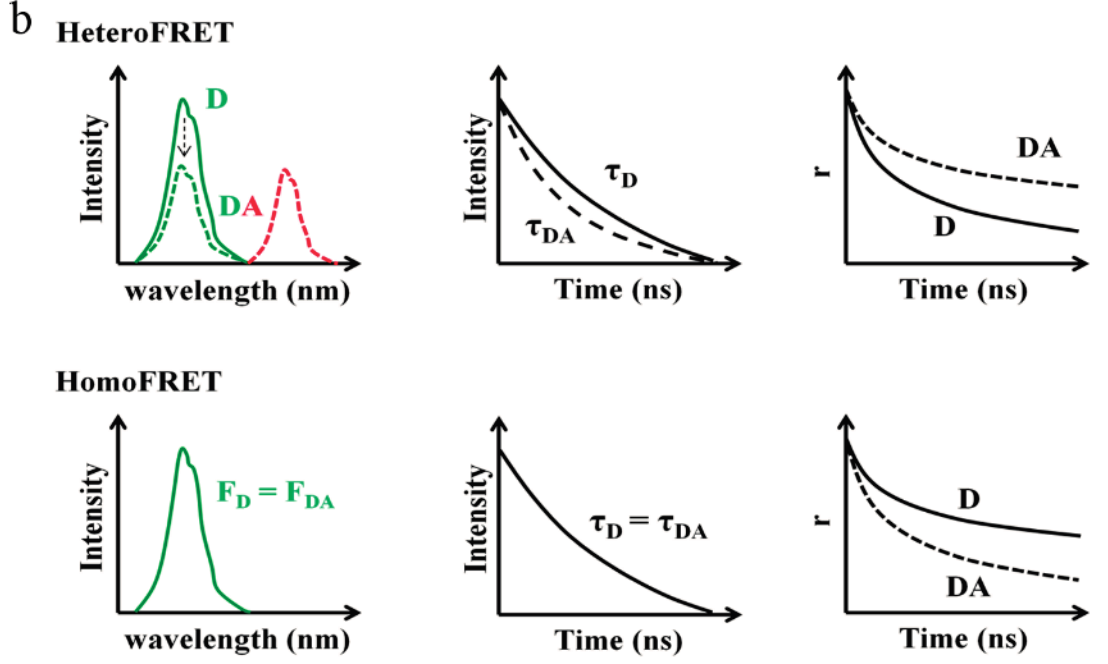
Figure 3. ( a ) Schematic representation of types of FRET measurements based on photophysical features; and ( b ) This figure illustrates the effect of heteroFRET and homoFRET on fluorescence intensity ( left panels), fluorescence lifetime ( middle panels) and fluorescence anisotropy ( right panels). Here, “D” and “DA” quoted symbols, including the ones in the subscript, represent donor only and FRET samples. In heteroFRET, donors and acceptors are fluorophores with different spectroscopic features. In the upper graph in the left panel, the emission of donor and FRET samples on excitation by the donor excitation wavelength are depicted for simplicity. The green and red curves correspond to the donor and acceptor emission spectra, respectively, in the left panels. In the lower graph in the left panel, there is only a green curve since both the donor and the acceptor are spectroscopically identical. In the middle and right panels, only the time-dependent donor emission (middle) and anisotropy (right) are shown in the absence and presence of the acceptor. The only manifestation of homoFRET is the decrease in anisotropy and no change in fluorescence intensity or fluorescence lifetime of the donor